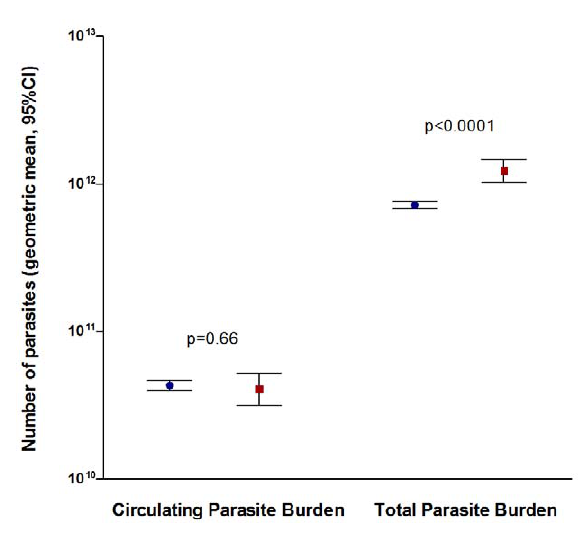
Figure 2. Comparison of circulating parasite burden and total parasite burden between surviving (blue circles, n=3,070) and fatal (red squares, n=327) cases. Circulating parasite burden was calculated from the peripheral blood parasitaemia and the total parasite burden was estimated from plasma Pf HRP2, including 3,397 patients with both detectable Pf HRP2 and malaria parasites on the peripheral